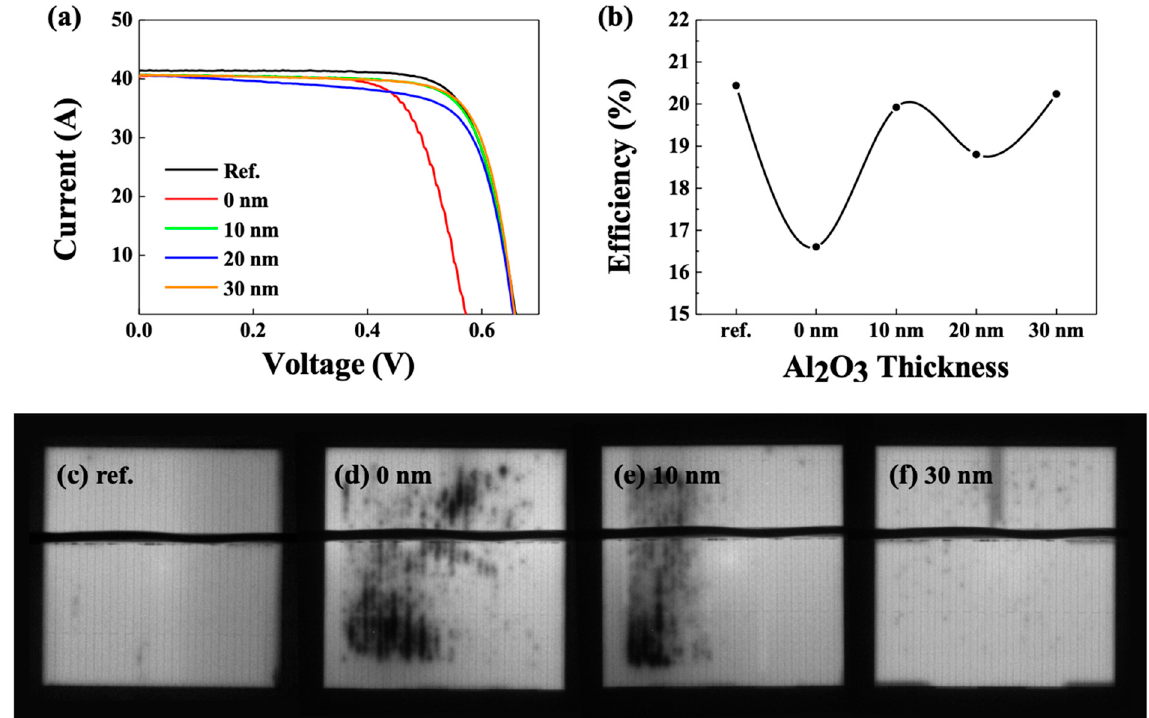
Figure 4. Characterization results of PERC cells after the accelerated PID test. ( a ) Light I–V, ( b ) effi- ciency changes, electroluminescent images obtained after the PID test; ( c ) ref—before the PID test, ( d ) without the Al 2 O 3 layer, ( e ) 10 nm Al 2 O 3 , and ( f ) 30 nm Al 2 O 3 .